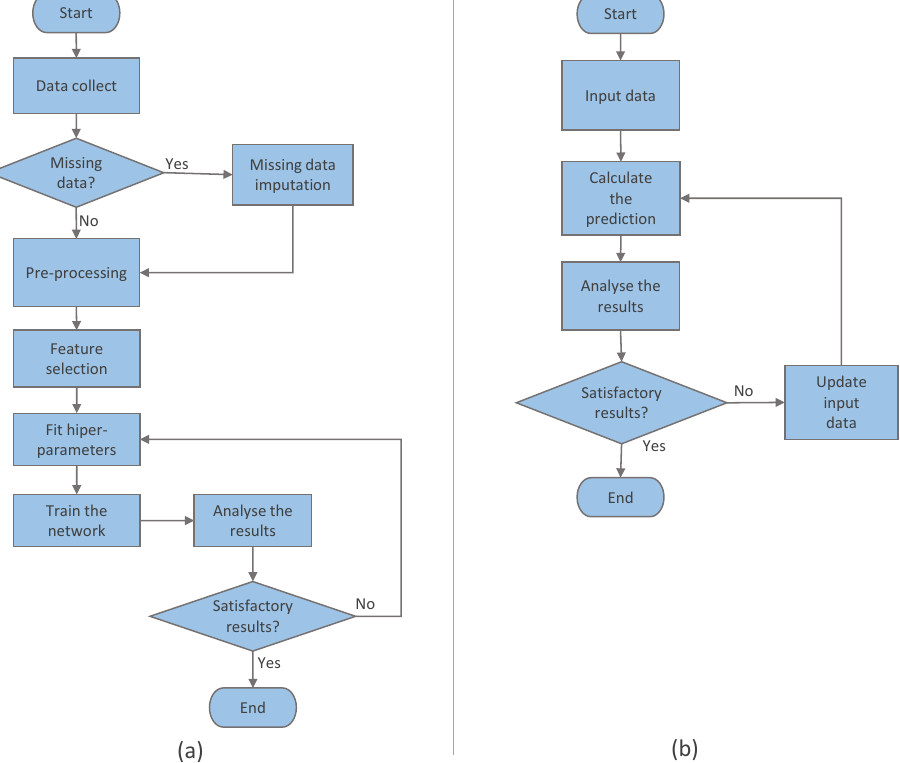
Figure 4. Processing flow. ( a ) Training step. ( b ) Prediction